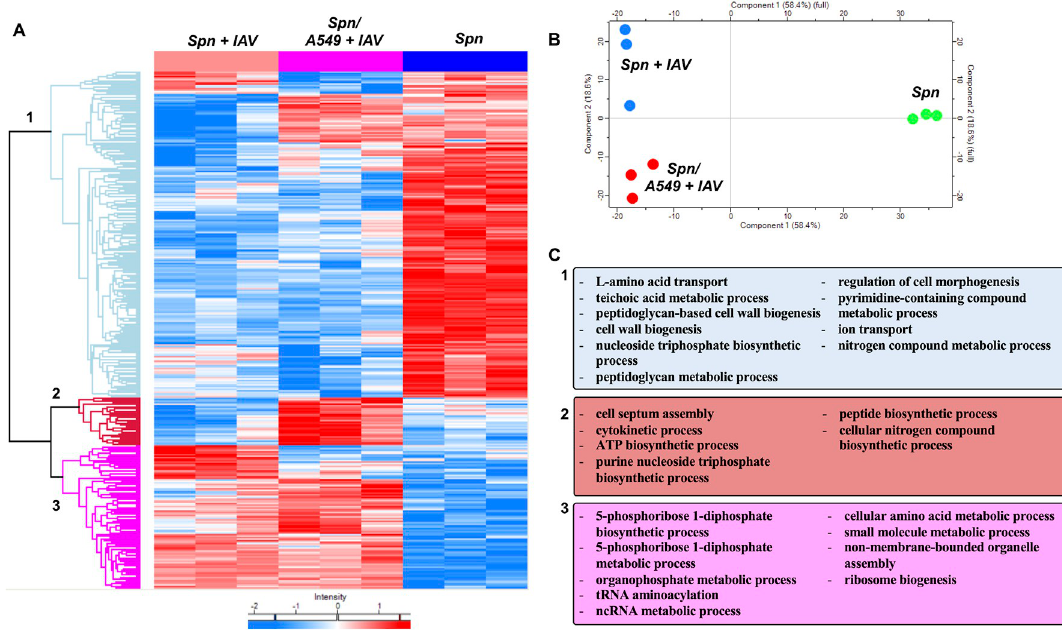
Fig 7. Primary IAV infection of respiratory epithelial cells leads to additional alterations to the pneumococcal proteome. A549 respiratory epithelial cells were infected with IAV PR8 at an MOI of 2. Four hours post infection, cells were challenged with Spn at an MOI of 10 for an additional four hours. As controls Spn was grown in tissue culture media with or without IAV exposure for the duration of the experiment. ( A ) Proteomic changes of Spn after IAV challenge, in the presence of IAV infected A549 cells or mock challenge. Hierarchical clustering of label-free quantification (LFQ) intensities of significantly changed proteins (ANOVA, P � 0.05) revealed 3 distinct clusters. Their abundance profiles among the groups were plotted in the heatmap ( A ). ( B ) Principal component analysis denoting differences in Spn proteomic profiles. ( C ) Enriched GO biological process terms are indicated for each marked